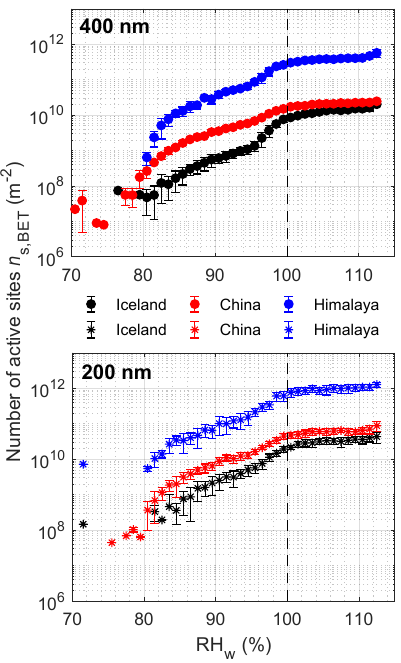
Figure 7. Average n s , BET values as a function of RH w for three washed dusts of 400 and 200nm in diameter at 238K. The val- ues are averaged into 1% RH w bins, and the error bars represent 1 standard deviation. The vertical dashed line is the water saturation (RH w = 100%)